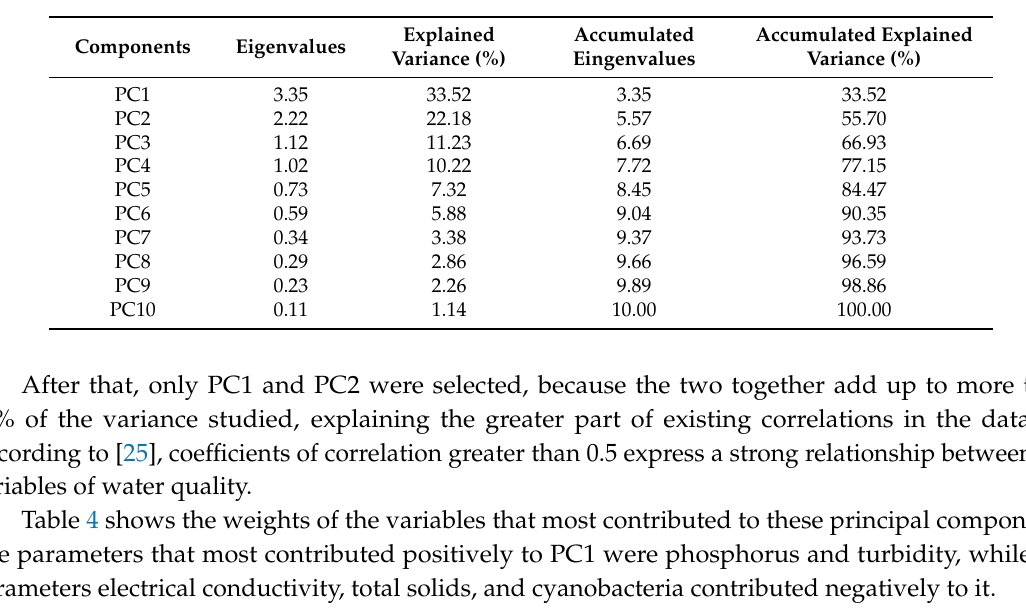
Table 3. Eigenvalues and explained variance of the variables.